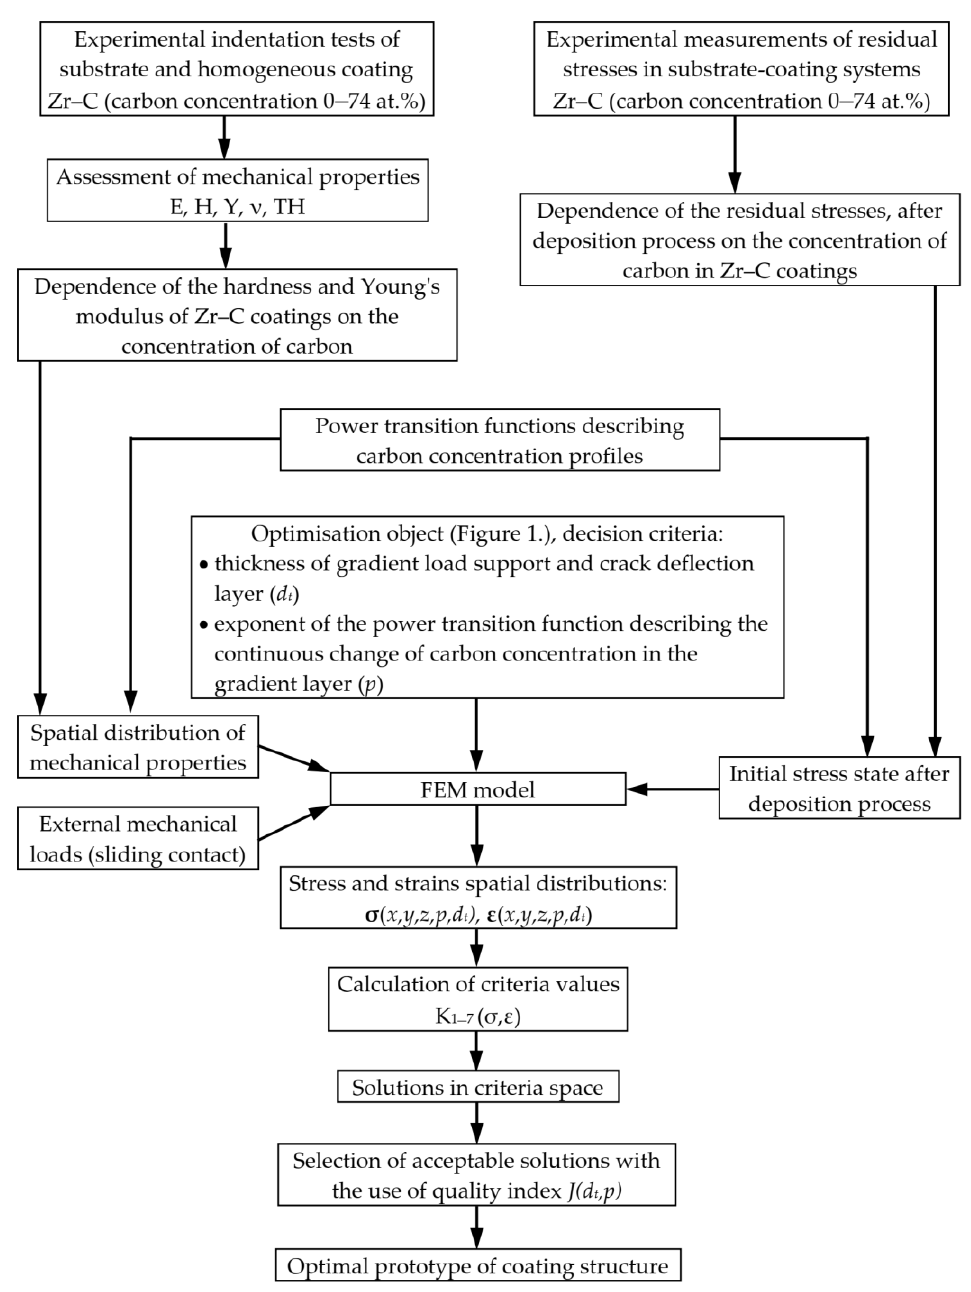
Figure 3. Scheme of the optimisation